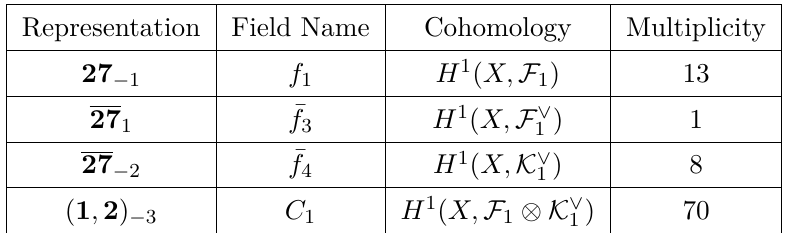
Table 1 . Field content of the E 6 × U(1) theory determined by the bundle V X in (5.20) which decomposes as V = K on a stability X 1 ⊕ F 1